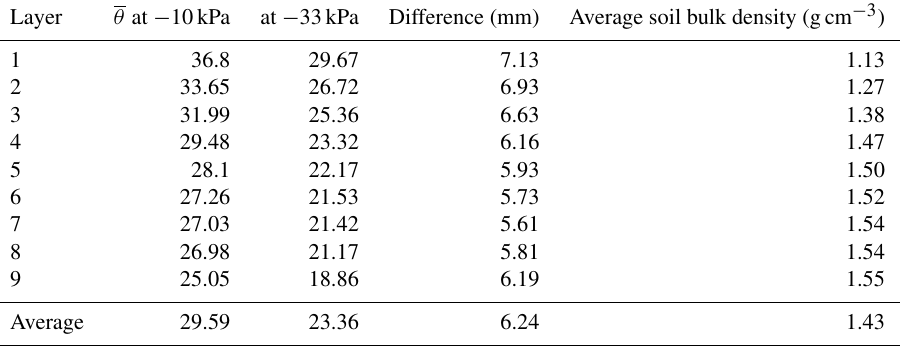
Table 3. Average soil moisture content at matric potentials − 10 and − 33kPa and average soil bulk density for discrete layers of the soil profile. The average was calculated for all soils in the dataset. Each layer could have different depths for individual soils used in the average.